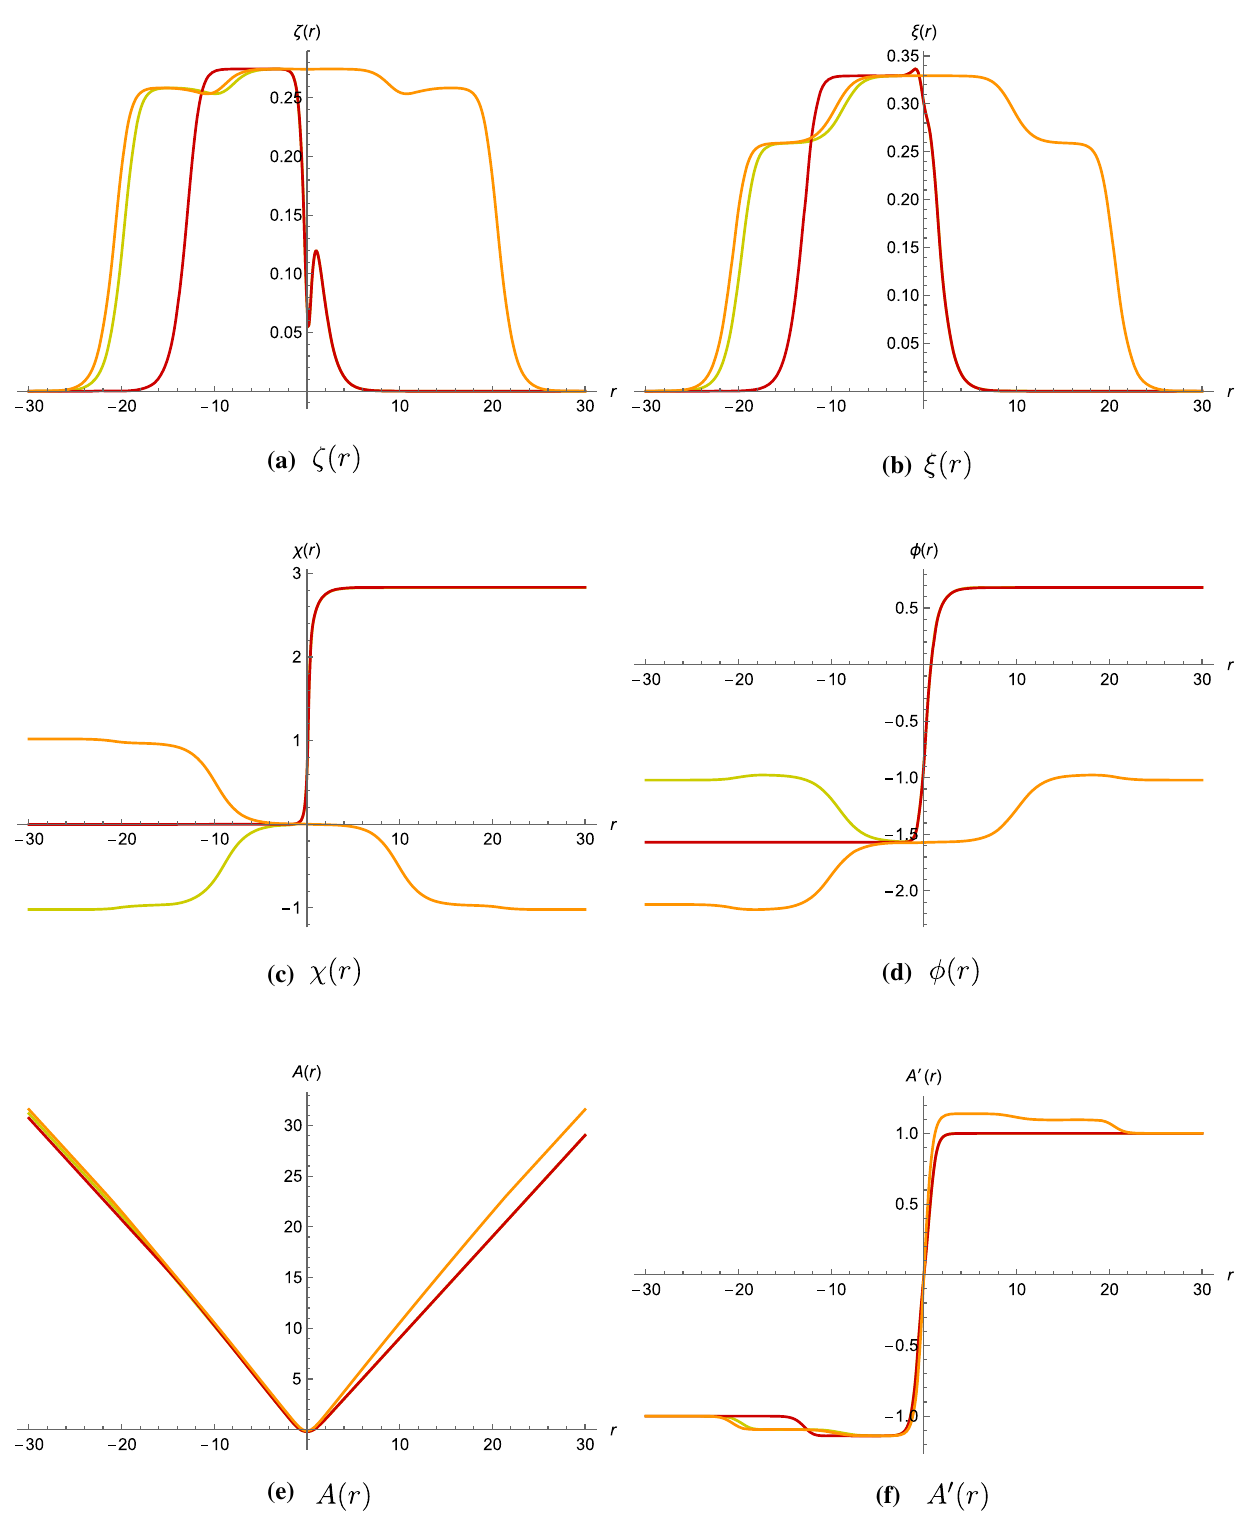
Fig. 8 Profiles of scalar fields (ζ,ξ,χ,φ) and the warped factor A for SO ( 8 )/ U ( 3 ) Janus together with SO ( 8 )/ G 2 and G 2 / G 2 solutions that flow to the U ( 3 ) critical point as functions of the radial coordinate